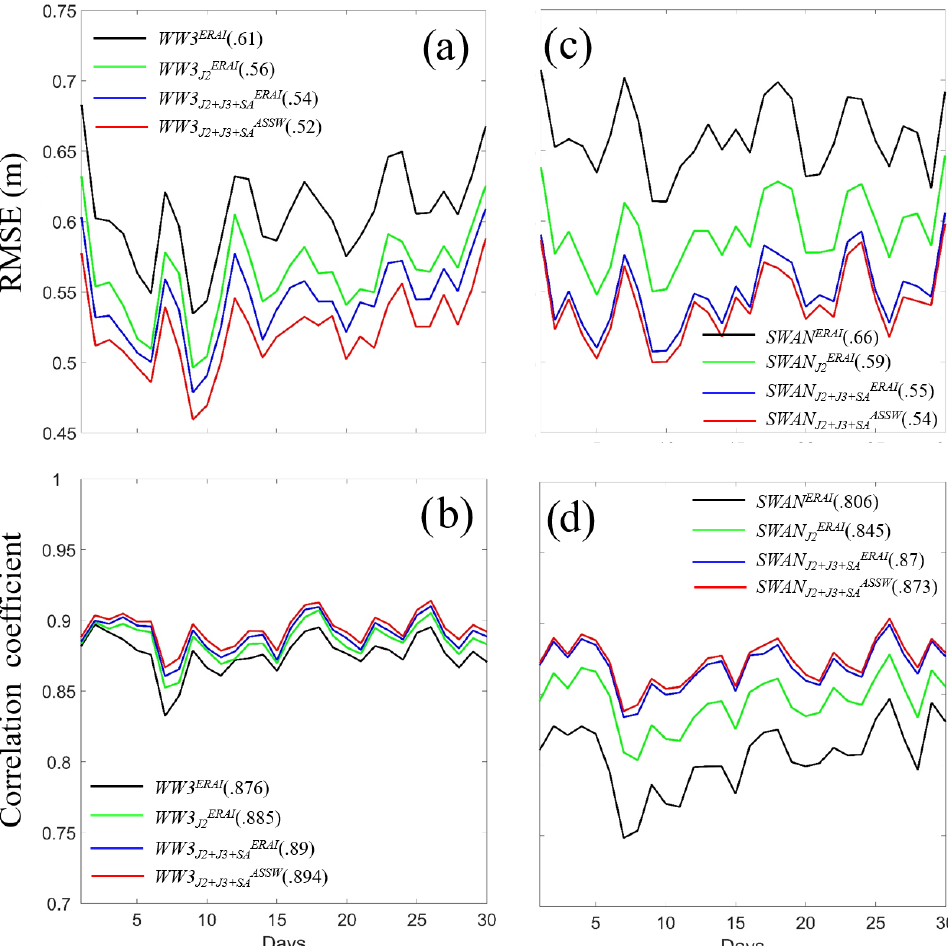
Figure 7. Time series of RMSEs (a, c) and spatial correlation coefficients (b, d) of WW3 (a, b) and SWAN (c, d) produced by the model control run (black, denoted as WW3 ERAI and SWAN ERAI ) and the assimilation using the data from one (green, denoted as WW3 ERAI and SWAN ERAI ) and three satellites (blue, denoted as WW3 ERAI J2 J2